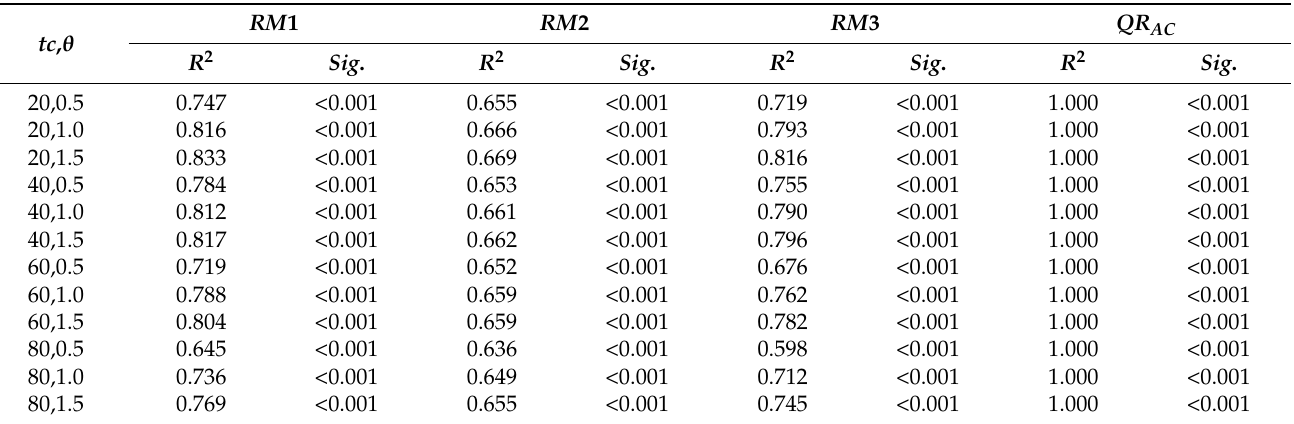
Table 4. Quality robustness correlation